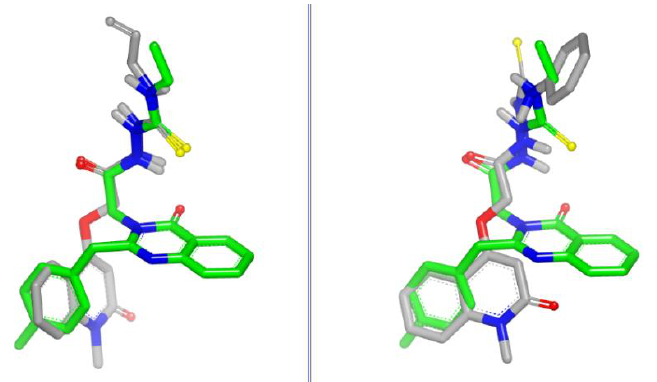
Figure 5. ROCS visualization of compound 5a (left, grey color) and compound 5c (right, grey color) overlaid with lead 1 (green color).